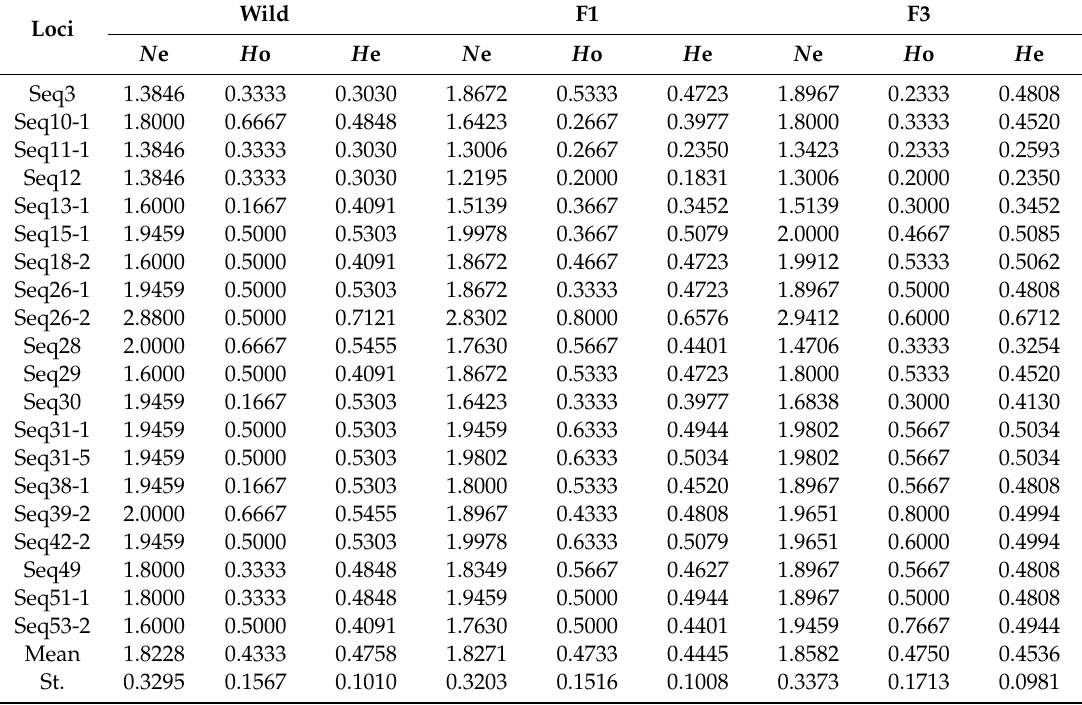
Genetic parameters of six rare minnow populations based on 20 single nucleotide polymorphisms